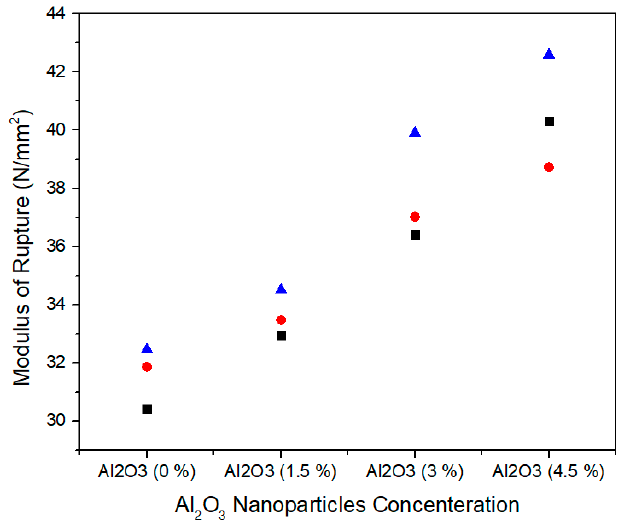
Figure 14. Numerical values of modulus of rupture (MOR) of various treatments of alumina nanoparticles. alumina